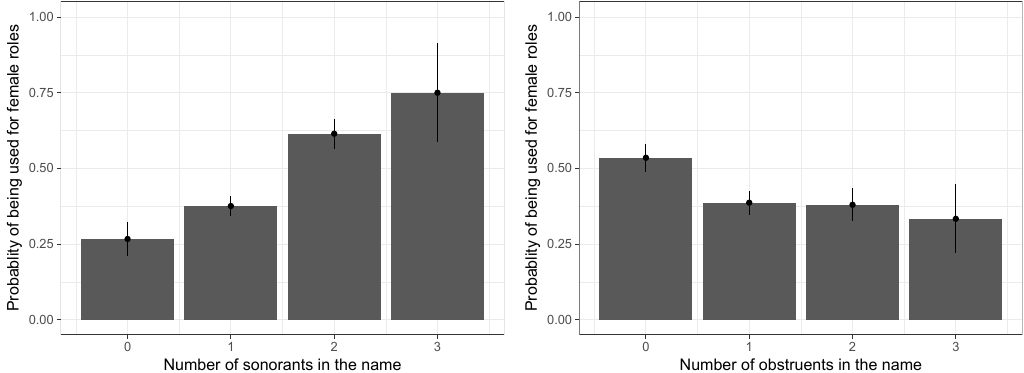
Figure 1: The effects of sonorants and obstruents on the gender choice in Takarazuka names. The error bars are standard